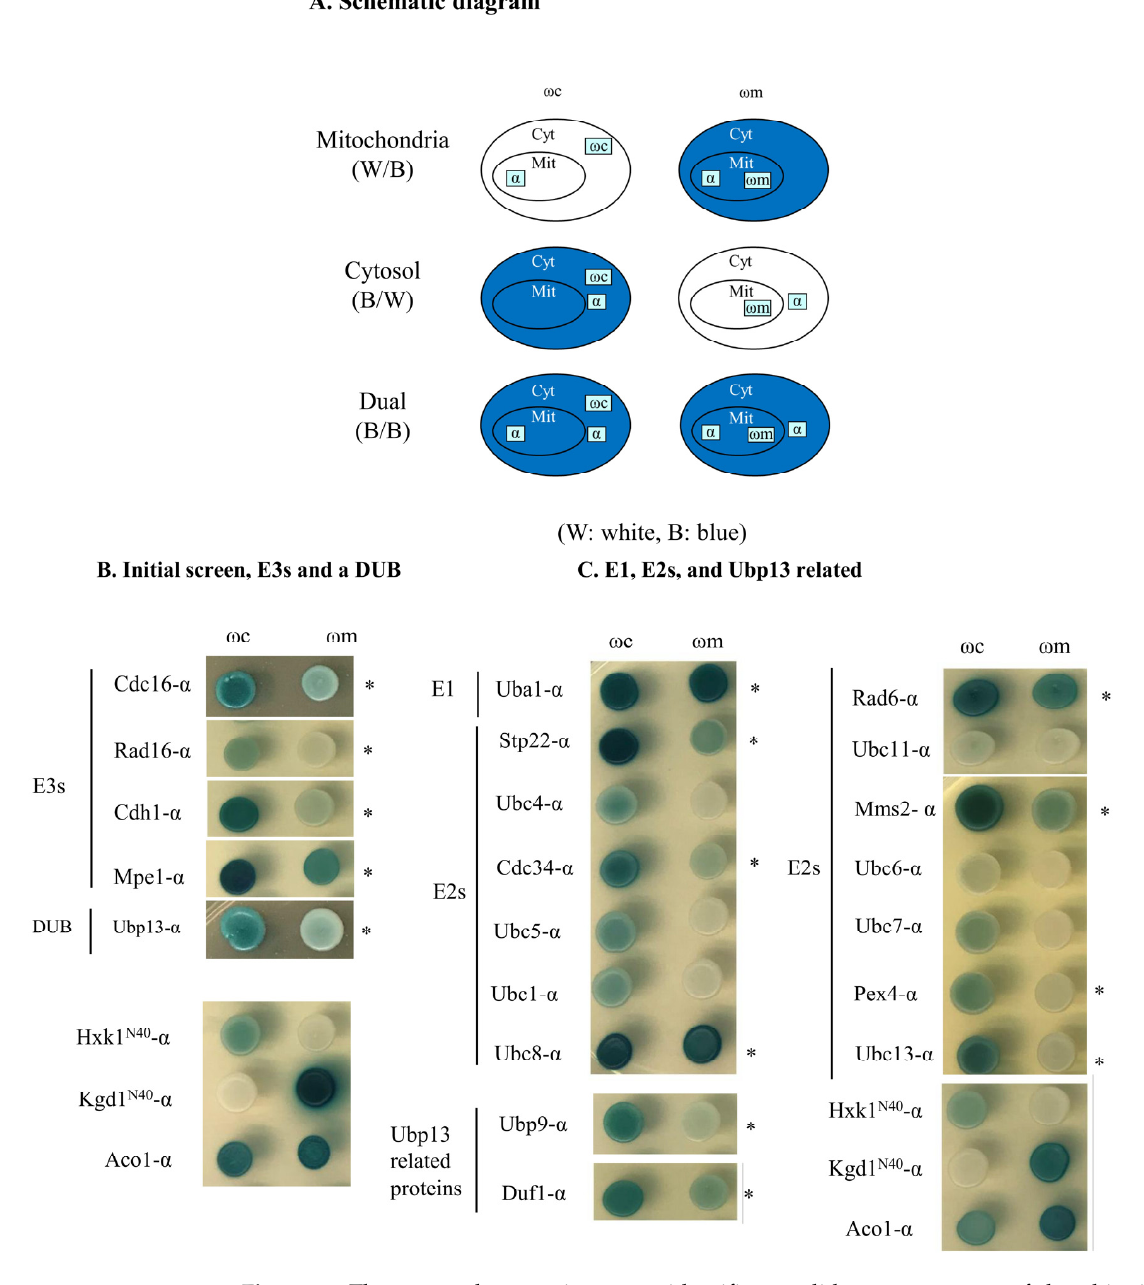
Figure 1. The α -complementation assay identifies candidate components of the ubiquitination machinery in mitochondria. ( A ) Schematic diagram of the α -complementation assay. Proteins of interest were fused with the α -fragment of β -galactosidase and expressed in cells with the ω -fragment present either in cytosol (Cyt) or mitochondria (Mit). If α and ω fragments co-localize in the same compartment, the cell colony color will be blue, and if the two fragments of β -galactosidase are present in separate compartments, the cell colony color will be white. ( B ) Initial screen, E3s and a DUB are targeted to mitochondria. Four E3s, including Cdc16, Rad16, Cdh1, MPE1, and a DUB, Upb13, were detected in mitochondria in the initial α -complementation screen of hundreds of proteins not known to be mitochondrial. N-terminal 40 amino acids of Hxk1 (Hxk1N40) and Kgd1 (Kgd1N40) are cytosolic and mitochondrial markers, respectively, and Aco1 is a dual-targeted marker. ( C ) Mitochondrial targeting of E1, E2s and Ubp13-related proteins. Uba1, Stp22, Cdc34, Ubc8, Rad6, Mms2, Pex4, Ubc13, Ubp9, and Duf1 are mitochondrial positive by the α -complementation assay. * indicates a blue color with ω m.